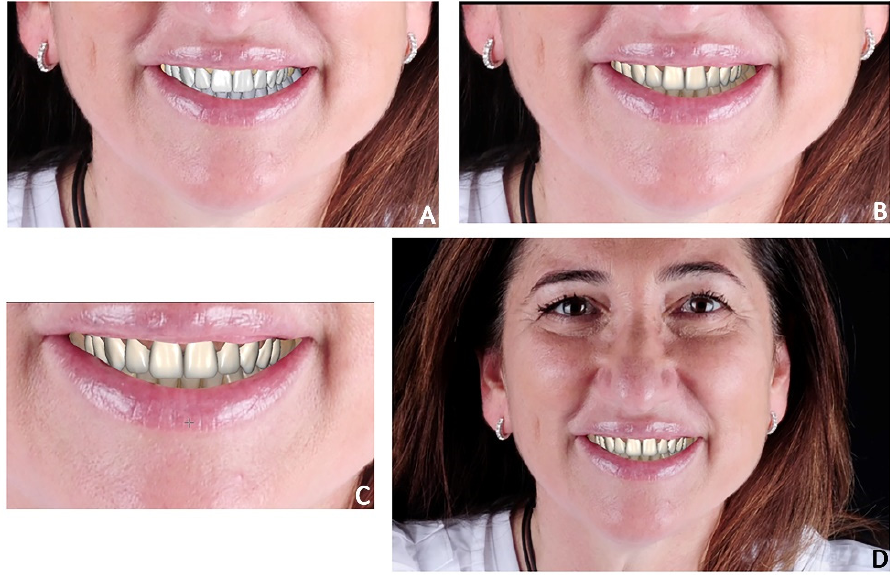
Figure 3. Case 1. Orthodontic set-up for staging movement for clear aligners therapy (Invisalign Go). ( A ) Pre-staged occlusal view; ( B ) post-staged occlusal view; ( C ) post-staged frontal view.